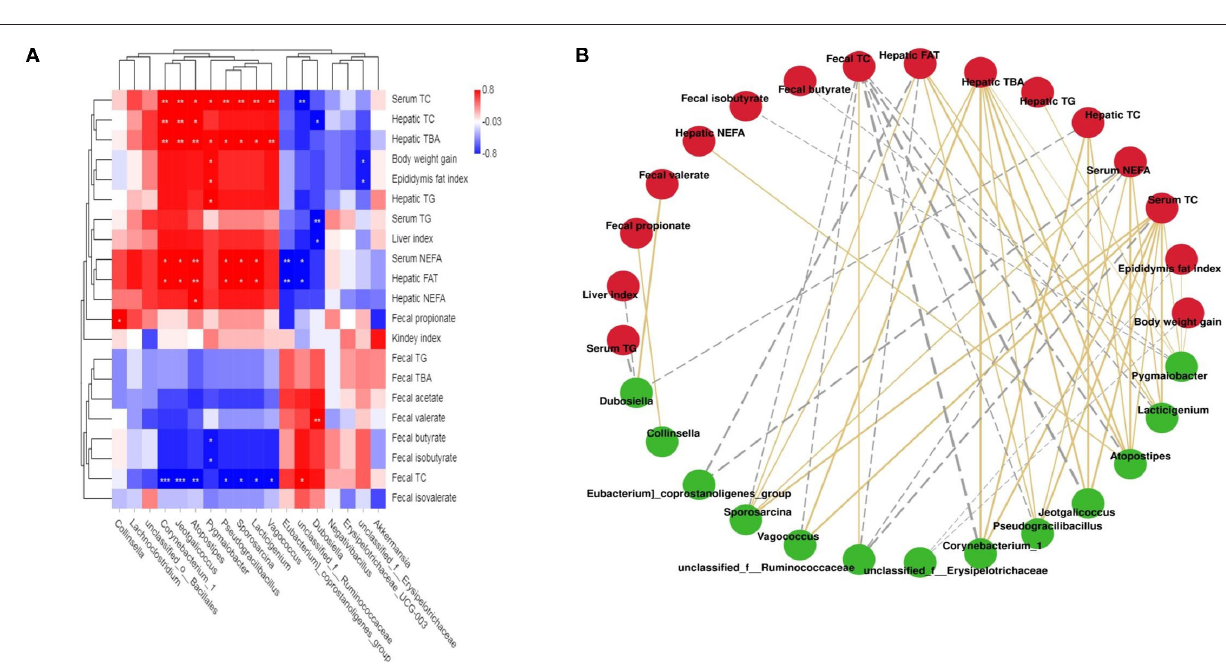
enrichment analysis of differential liver metabolites ( Figures 7E